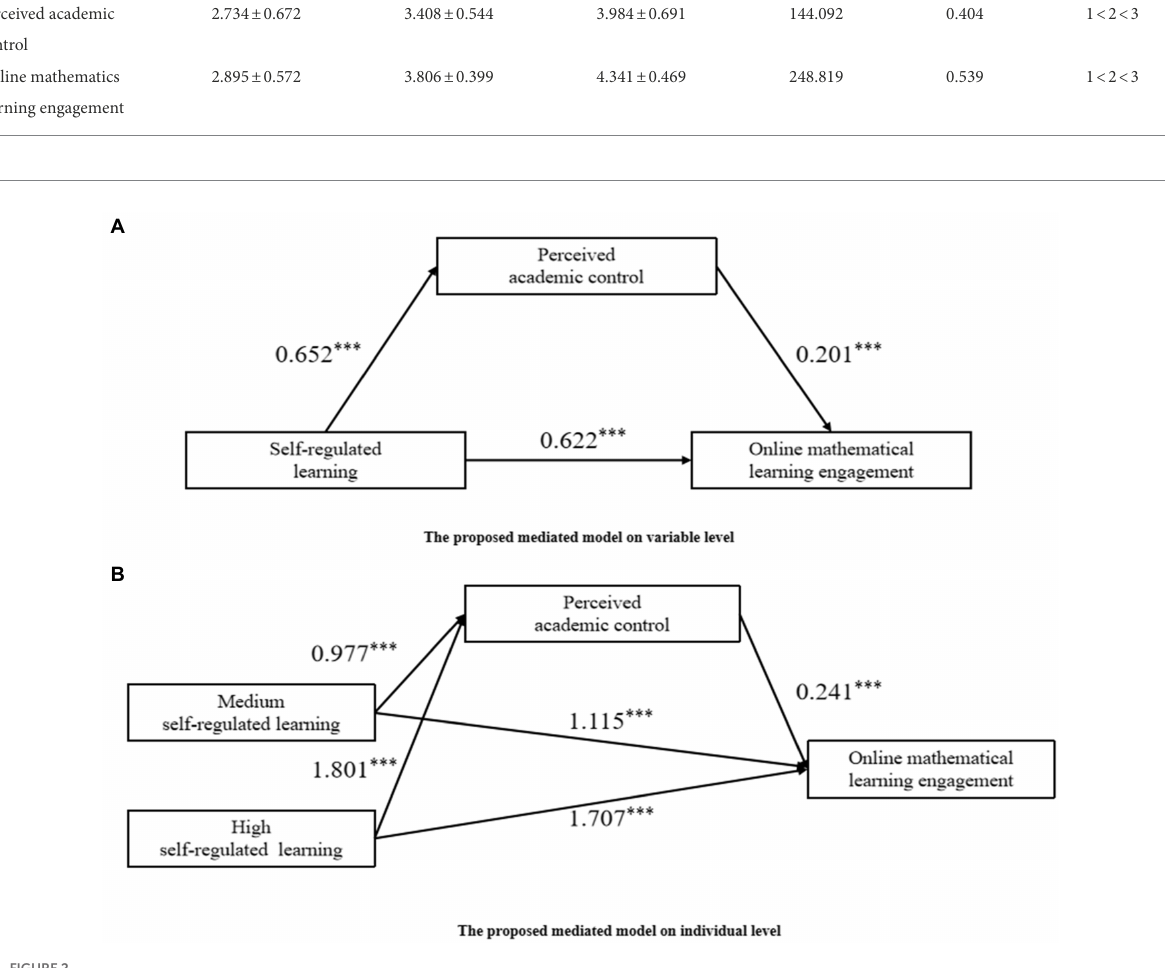
Figure 2A showed the results of this test. Self-regulated learning significantly and positively predicted online mathematics